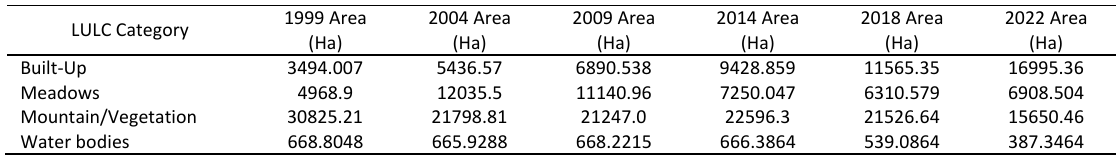
Table 4: Land Use‐Land Cover Statistics Table 4: Land Use-Land Cover Statistics